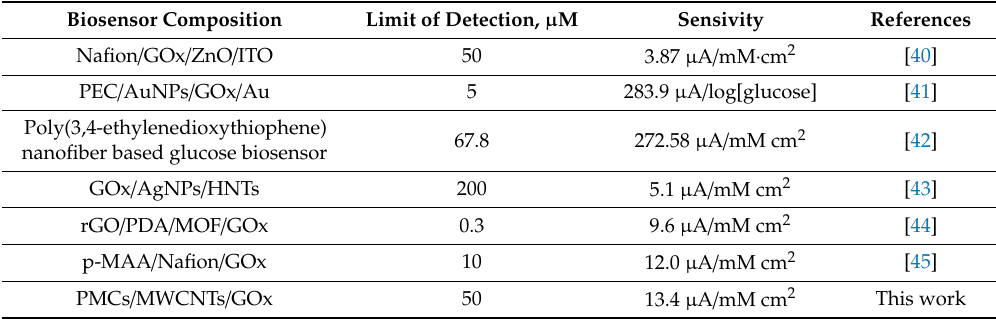
Table 3. Sensitivity and limit of detection for some glucose biosensors based on GOx.